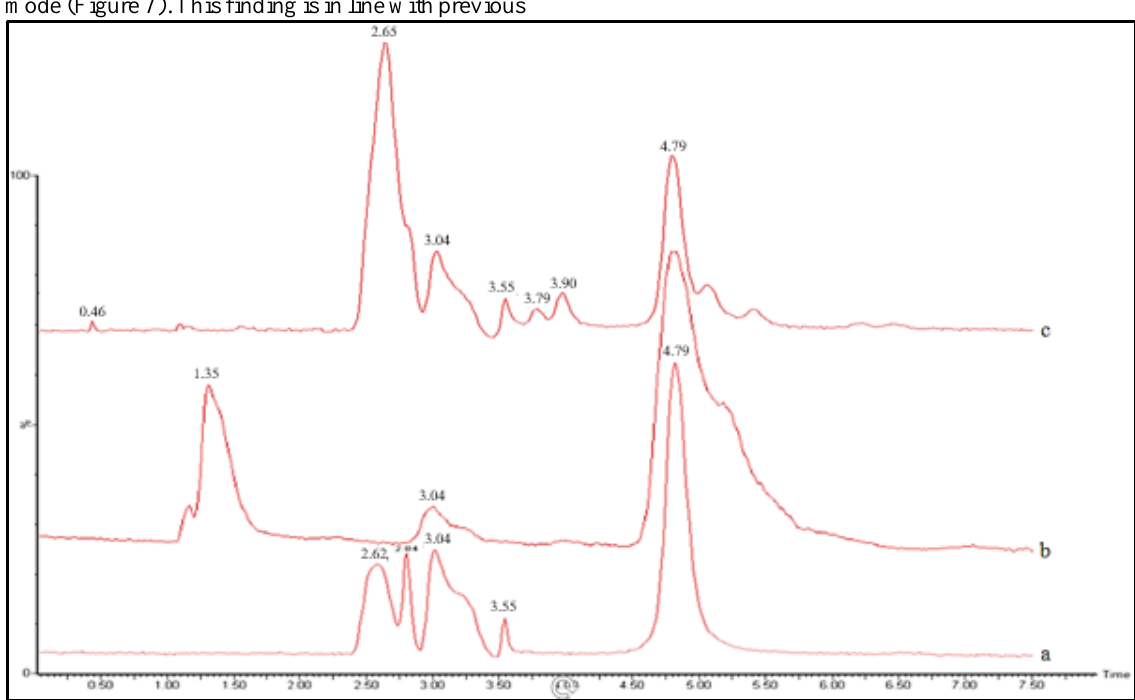
Figure 6. The chromatogram of the CGA standard (a), EtOAc extract (b), and microcapsule (c). Negative